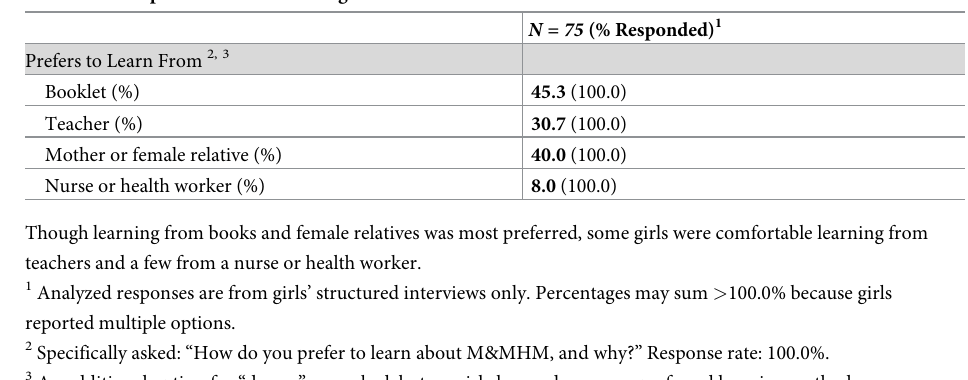
Table 6. Girls’ preferences for learning about